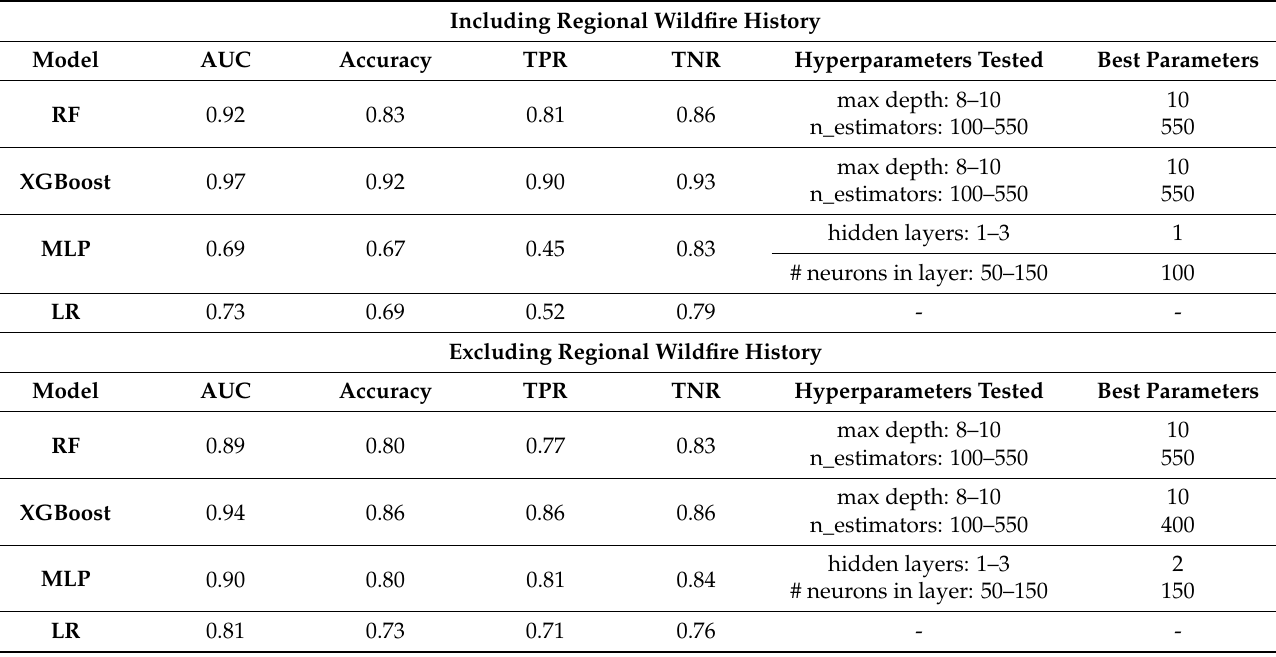
Table 2. Summary of model performances—wildfire occurrence. Including Regional Wildfire